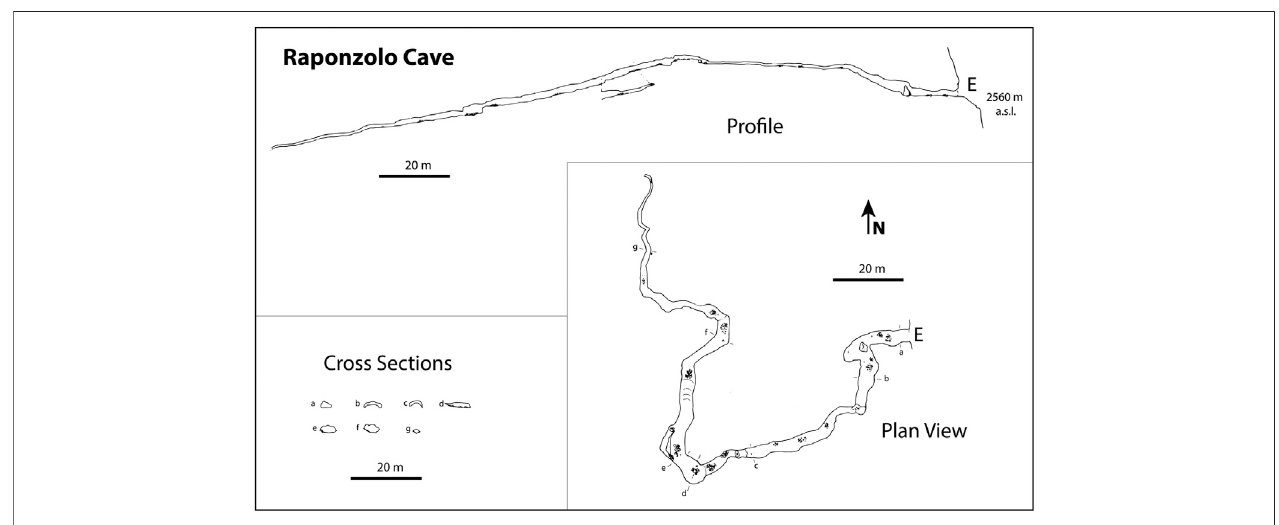
FIGURE 4 | Topographic map of Raponzolo Cave (survey GST-SAT